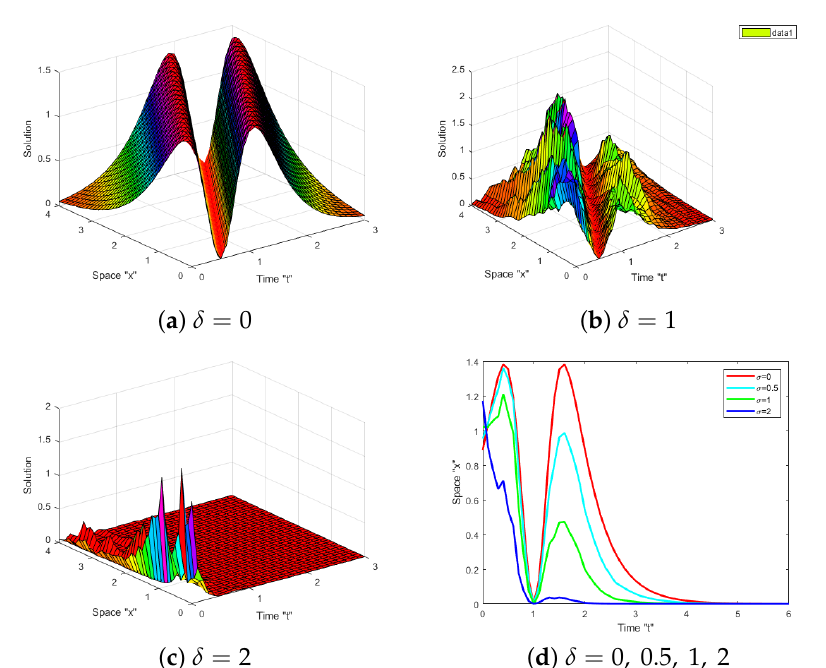
Figure 2. ( a – c ) Three-dimensional graph of solution W ( x , y , z , t ) in Equation (32) for various δ = 0, 1, 2; ( d ) two-dimensional graph for various δ = 0, 1,